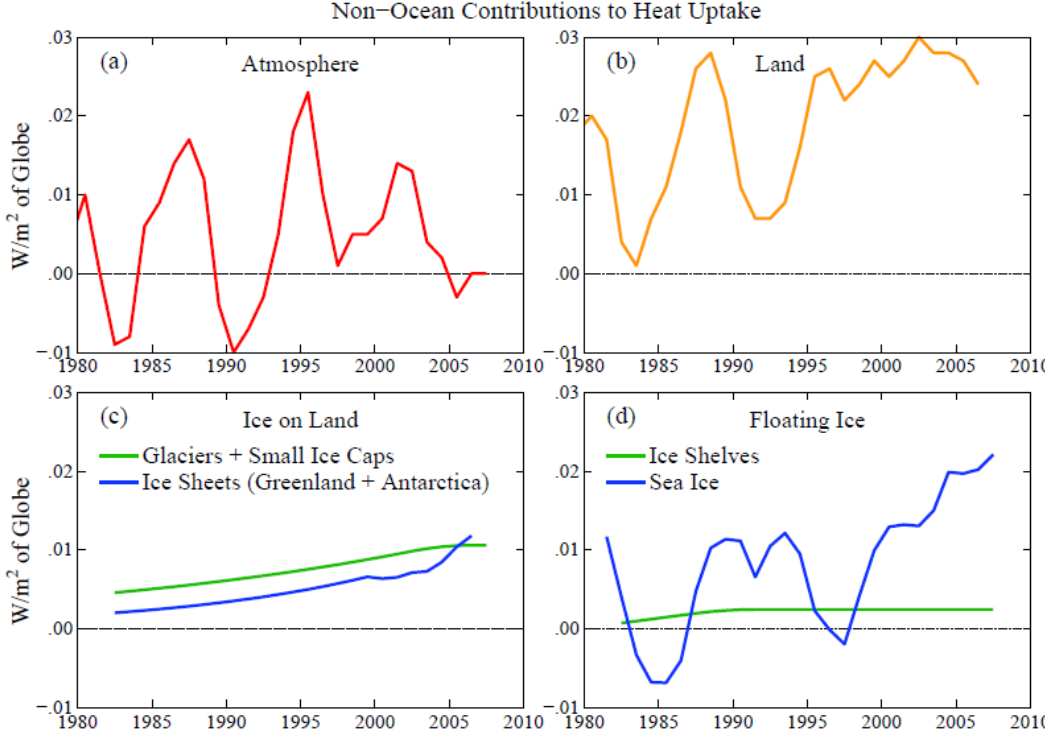
Fig. 8. Contributions to planetary energy imbalance by processes other than ocean heat uptake. Annual data are smoothed with moving 6-year linear trends.